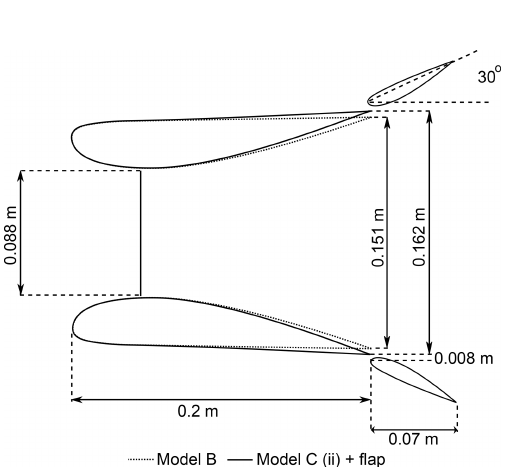
Figure 1. Schematic of flow around a multi-element ducted wind turbine.